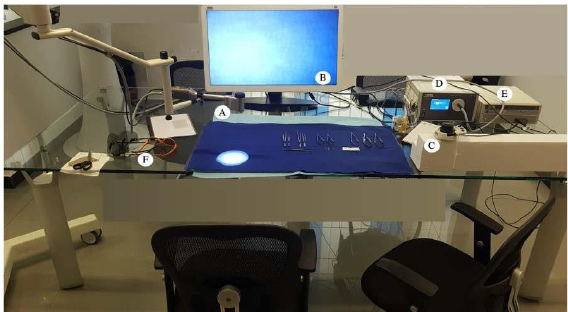
Figure 1. The study setting. The microsurgical instrumentation and the complete exoscope set are visible. The latter includes: ( A ) the two compact and light cameras coupled at the tip of a small crane; ( B ) a three-dimensional 4k high-resolution video display; ( C ) a control joy-stick (Pilot) to zoom, focus and finely adjust the camera position; ( D ) the light-source; ( E ) the computer hardware; ( F ) several pairs of three-dimensional